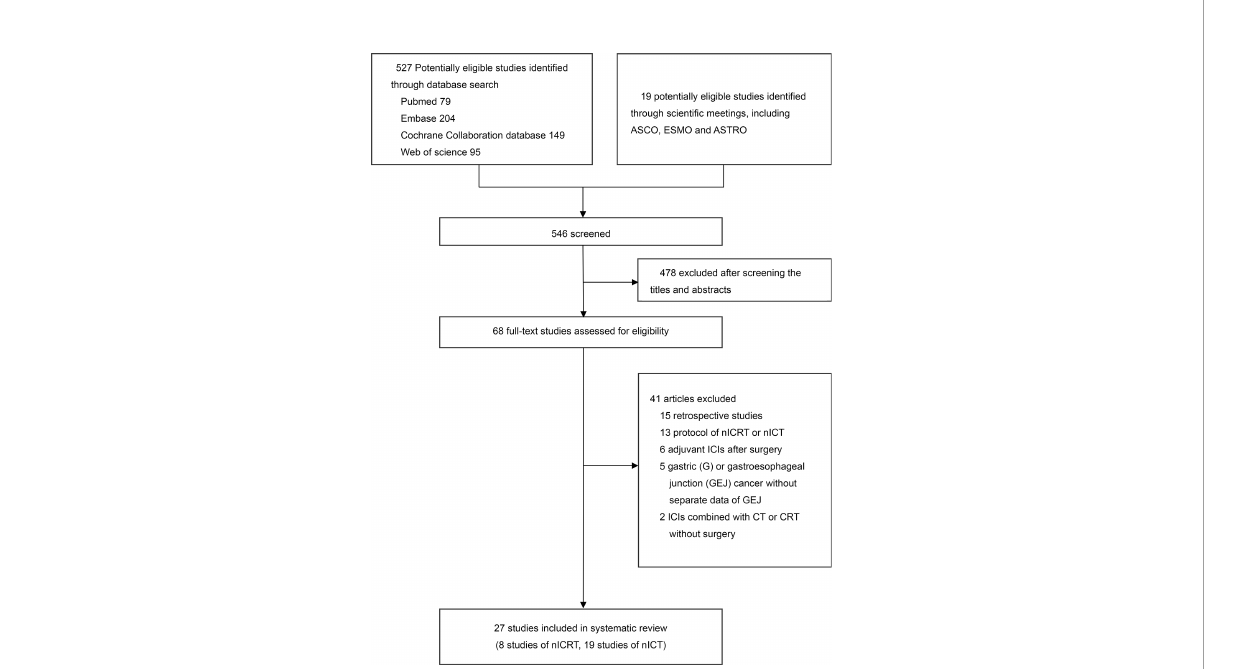
FIGURE 1 Literature search and selection. nICRT, neoadjuvant immune checkpoint inhibitor in combination with chemoradiotherapy; nICT, neoadjuvant immune checkpoint inhibitor in combination with